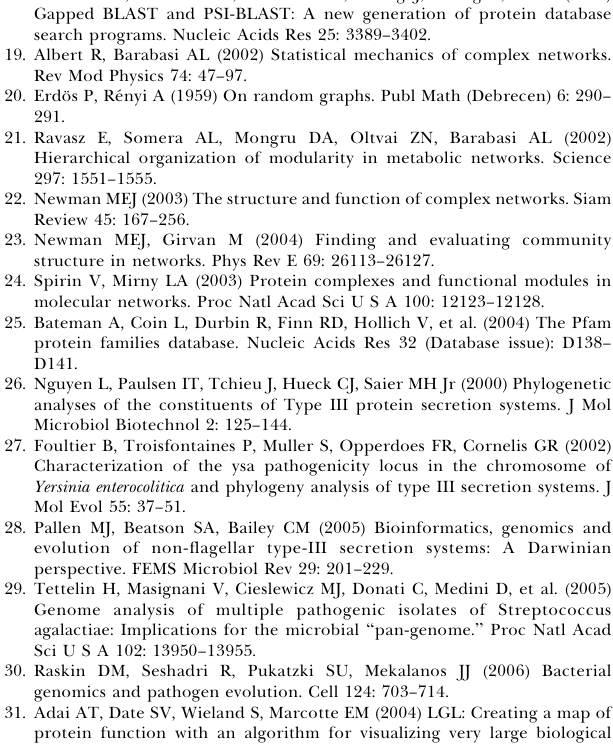
Table S3. Proteins Included in the Identified T3SS Detailed list of T3SS proteins shown in Figure 8A. Table S4. Proteins Included in the Identified T4SS Detailed list of T4SS proteins shown in Figure 8B. Table S5. Protein